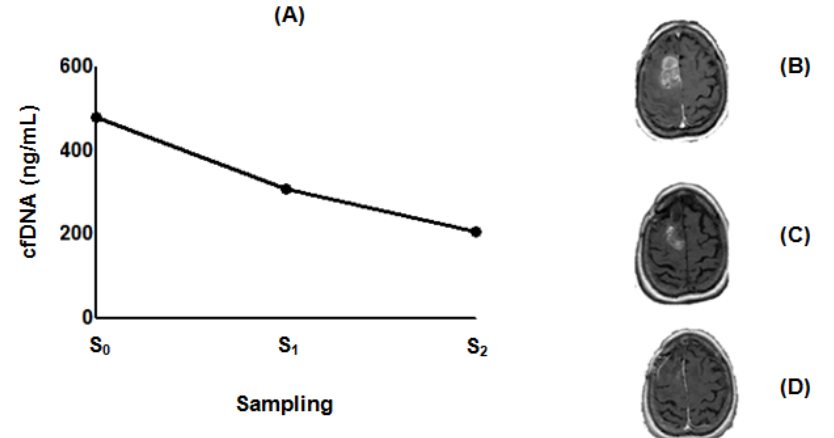
Figure 5. Figure of a GBM patient with a good response to ITN-POH based therapy. ( A ) cfDNA levels before and during treatment. Remarkable tumor mass identified by MRI at the time of protocol inclusion ( B ) and before ITN-POH therapy was accompanied by a high level of cfDNA ( A , S 0 = 479 ng/mL; October 2005). Therapy resulted in impressive tumor mass regression ( C ) and a marked decrease of cfDNA ( A , S 1 = 308 ng/mL; April 2007). MRI compatible with stable disease was observed after 4 years of ITN-POH therapy ( D ) and a two-fold decrease compared to initial cfDNA measurement ( A , S 2 = 205 ng/mL; December 2009).